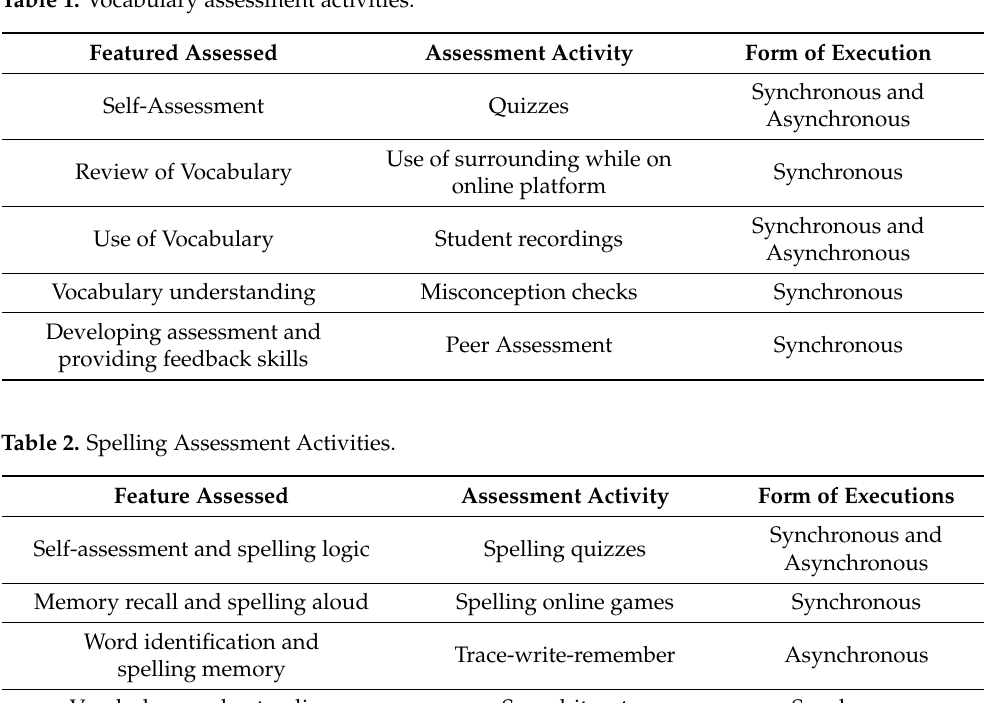
Table 1. Vocabulary assessment activities.